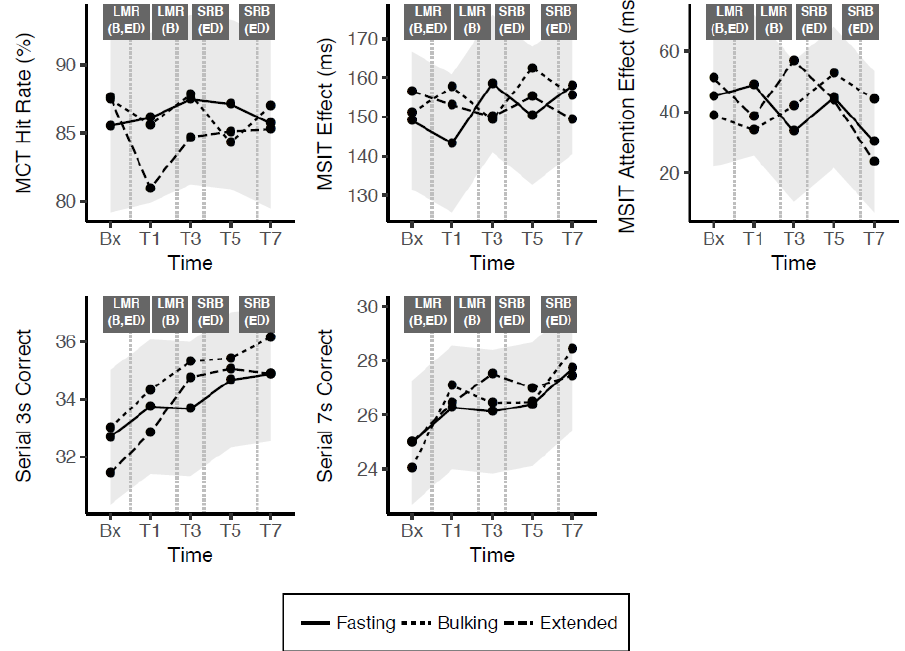
Figure 4. Change across the day in cognitive task outcome measures (shaded grey bands indi- cate 95% confidence interval for difference from fasting condition). Bx = baseline, T = Time(x), LMR = Liquid Meal Replacement, SRB = Snack Replacement Bar, B = Bulking, ED = Extended